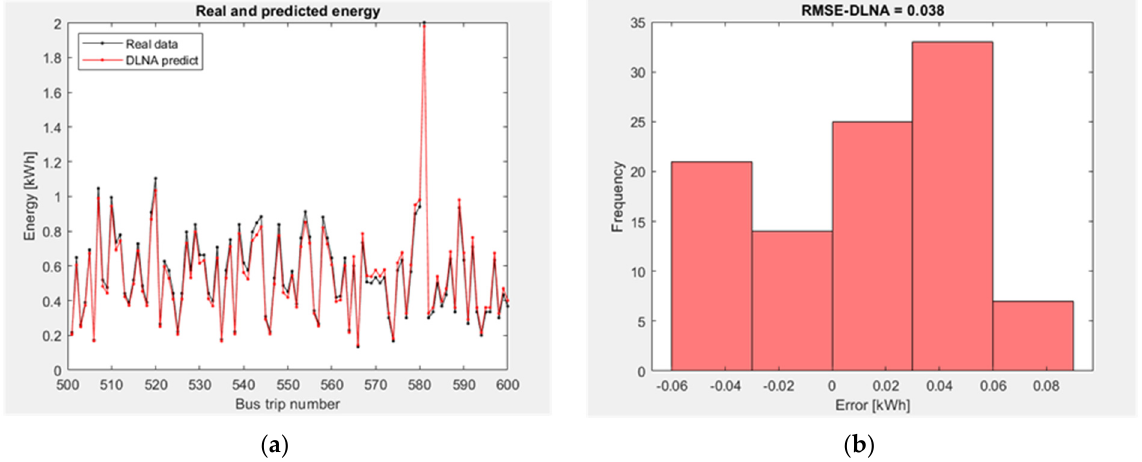
Figure 10. ( a ) Real and predicted energy consumption for test data from 501 to 600; ( b ) histogram for RMSE errors for DLNA networks for 100 test data.